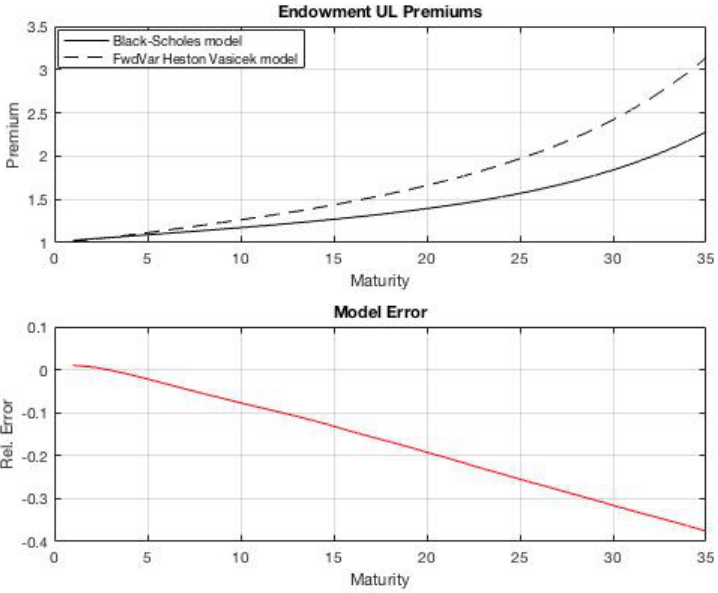
Figure 7. Single premiums for an endowment with benefits equal to 1 monetary unit, using the classical Black-Scholes with constant interest r = 1% and µ = 1.5%, σ = 4% and a Vasicek-Heston model with parameters S 0 = 1, µ = 1.5%, ¯ ν = 1%, ν 0 = 4%, κ = 10 − 3 , η = 10 − 2 , θ = r 0 = 1%, k = 0.3, σ =